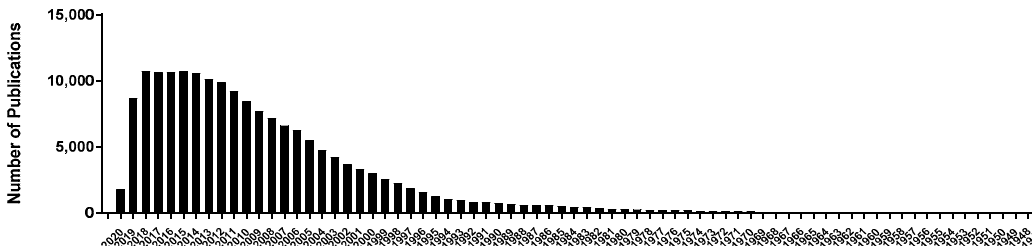
Figure 1. The number of publications on stress-related peptides by year available on PubMed